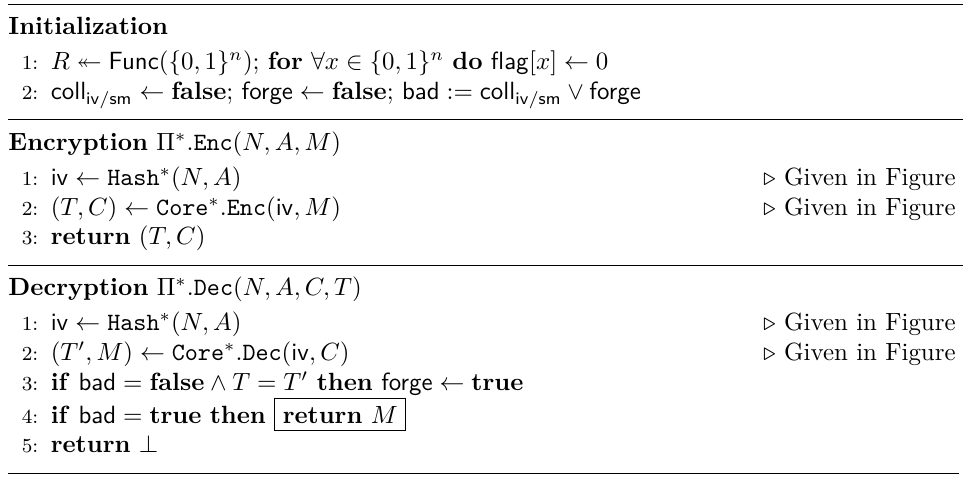
Figure 2: World 1 (without boxed statements) and World 2 (with boxed